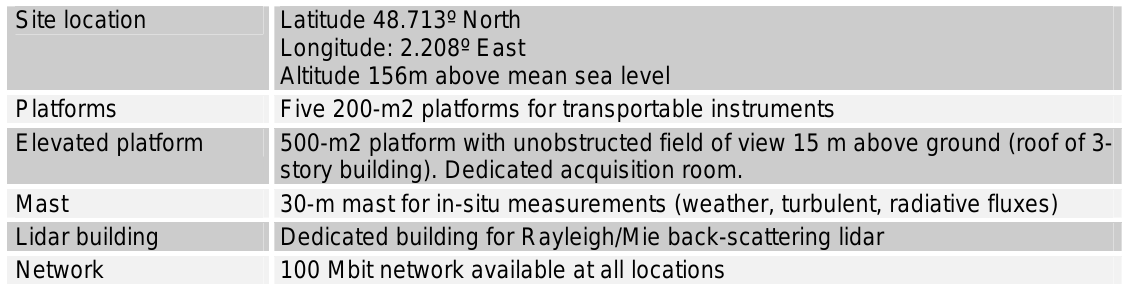
Fig. 1. Location of the SIRTA observatory on a World map in relation to other atmospheric observatories: ARM Program (USA), Chilboton Observatory (UK), and Cabauw experimental site (NL) described in Sect. 3.2. Table 1. Infrastructure of the SIRTA observatory. Table 1. Infrastructure of the SIRTA